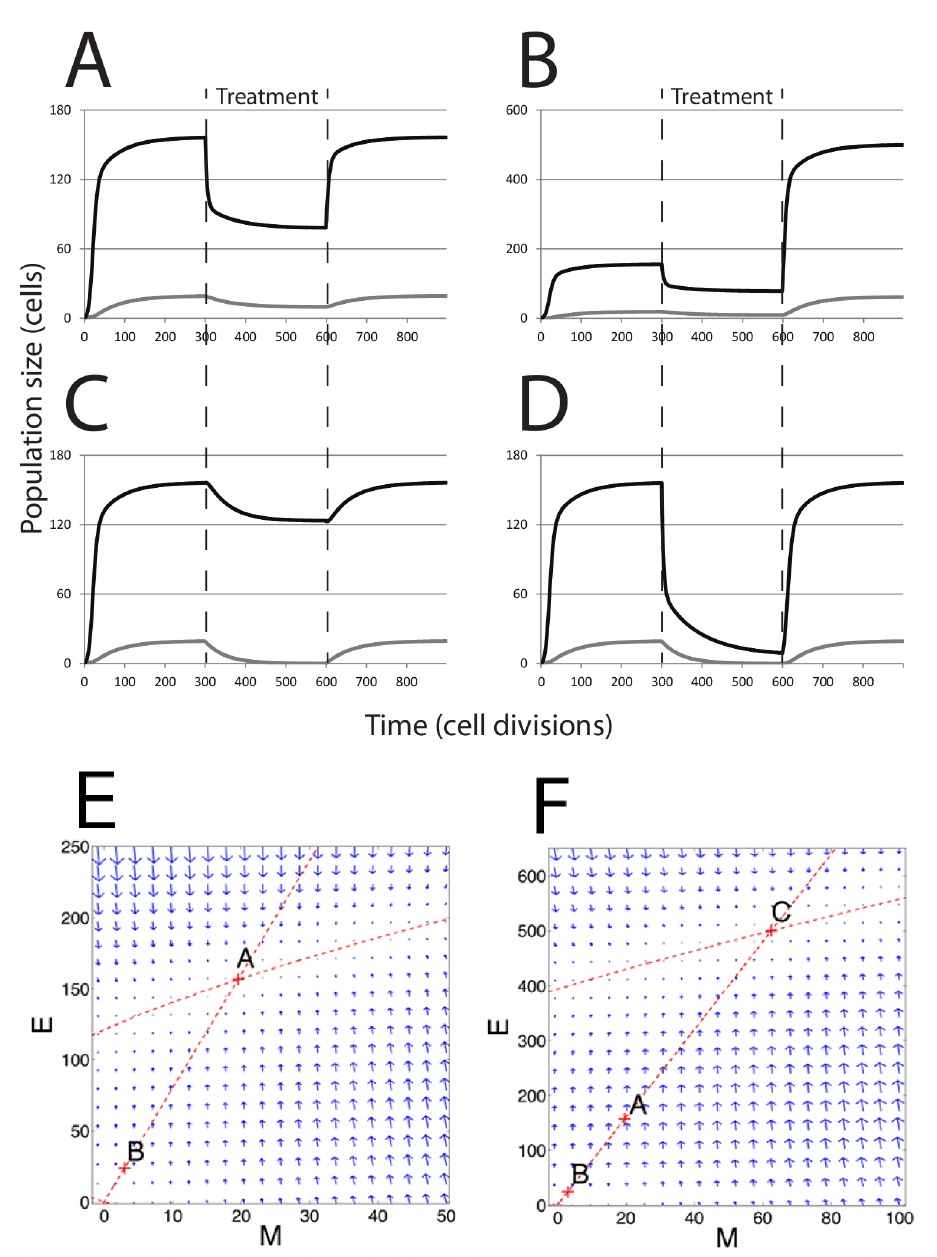
Figure 3. Population dynamics in response to chemotherapy. Modeling chemotherapeutic treatment and recurrence; tumor population dynamics before, during and after a treatment regime (denoted by the dashed vertical lines). ( A ) Treatment consisting of an agent that increased cell death ( β ) in the E cell population. At the end of treatment, β returns to 3 3 its pre-treatment level; ( B ) The E cell population acquires resistance mutations following treatment ( β is lower than before treatment); ( C ) Treatment consisting of an agent that 3 prevents EMT; ( D ) Treatment consisting of both β reduction and EMT prevention in 3 combined therapy. In (C) and (D), recovery was to original pre-treatment parameter values; ( E ) The phase plane plot shows the behavior of the system around the fixed Point A (pre-treatment parameter values) and nullclines. Point B marks the system state after treatment; ( F ) Phase plane plot around the fixed Point C; parameter values after E cells have acquired mutations. In both (E) and (F), the fixed points shown are the only stable fixed points for the system in this